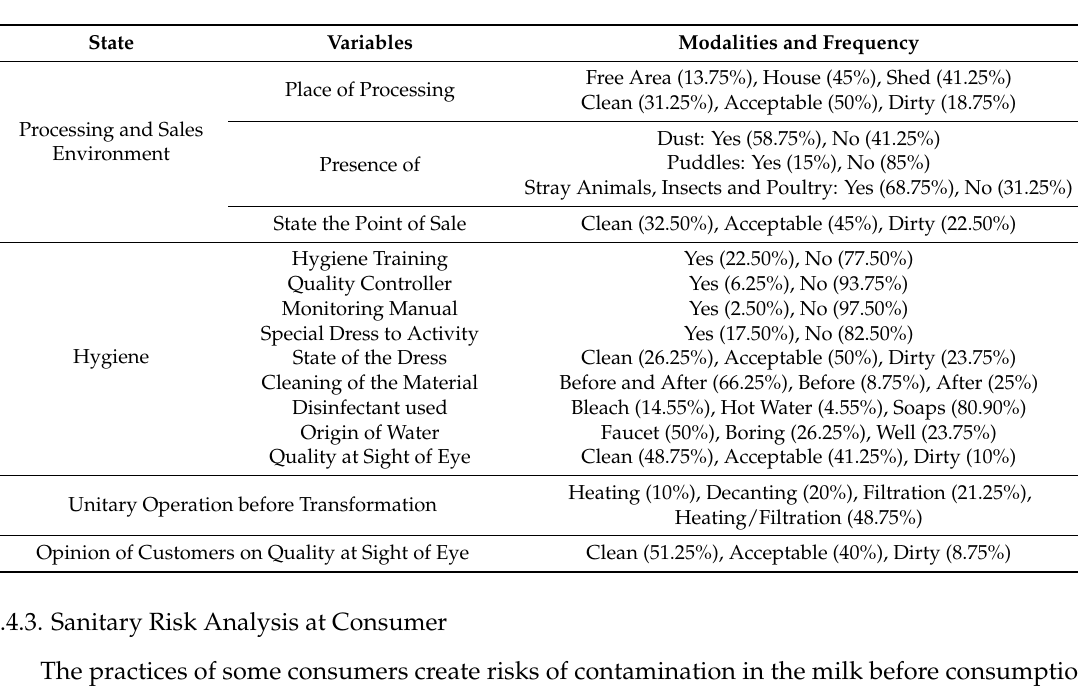
Table 5. Sanitary risks from processing to sale of milk.